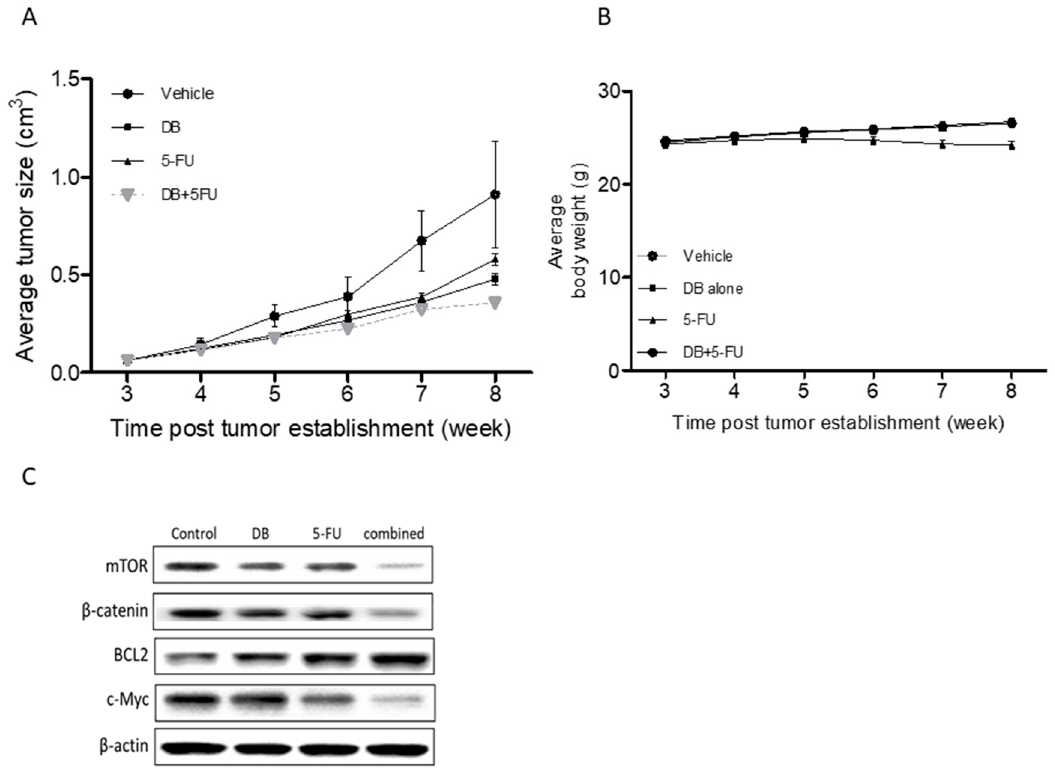
Figure 5. The DB and 5-FU combination suppressed 5-FU resistant DLD-1 tumorigenesis in vivo. ( A ) The tumor-size curve over time demonstrates that DB alone was more effective than delaying IGF1-treated DLD-1 cells, while the combination of DB and 5-FU was the most effective. ( B ) The body-weight curve over time shows that the average body weight of all the animals were not significantly different. ( C ) Western blot analysis of tumor samples harvested. Oncogenic markers, including mTOR, β -catenin, and c-Myc were all suppressed, while Bcl2 increased under DB treatment and showed up more prominently in the combination treatment group.